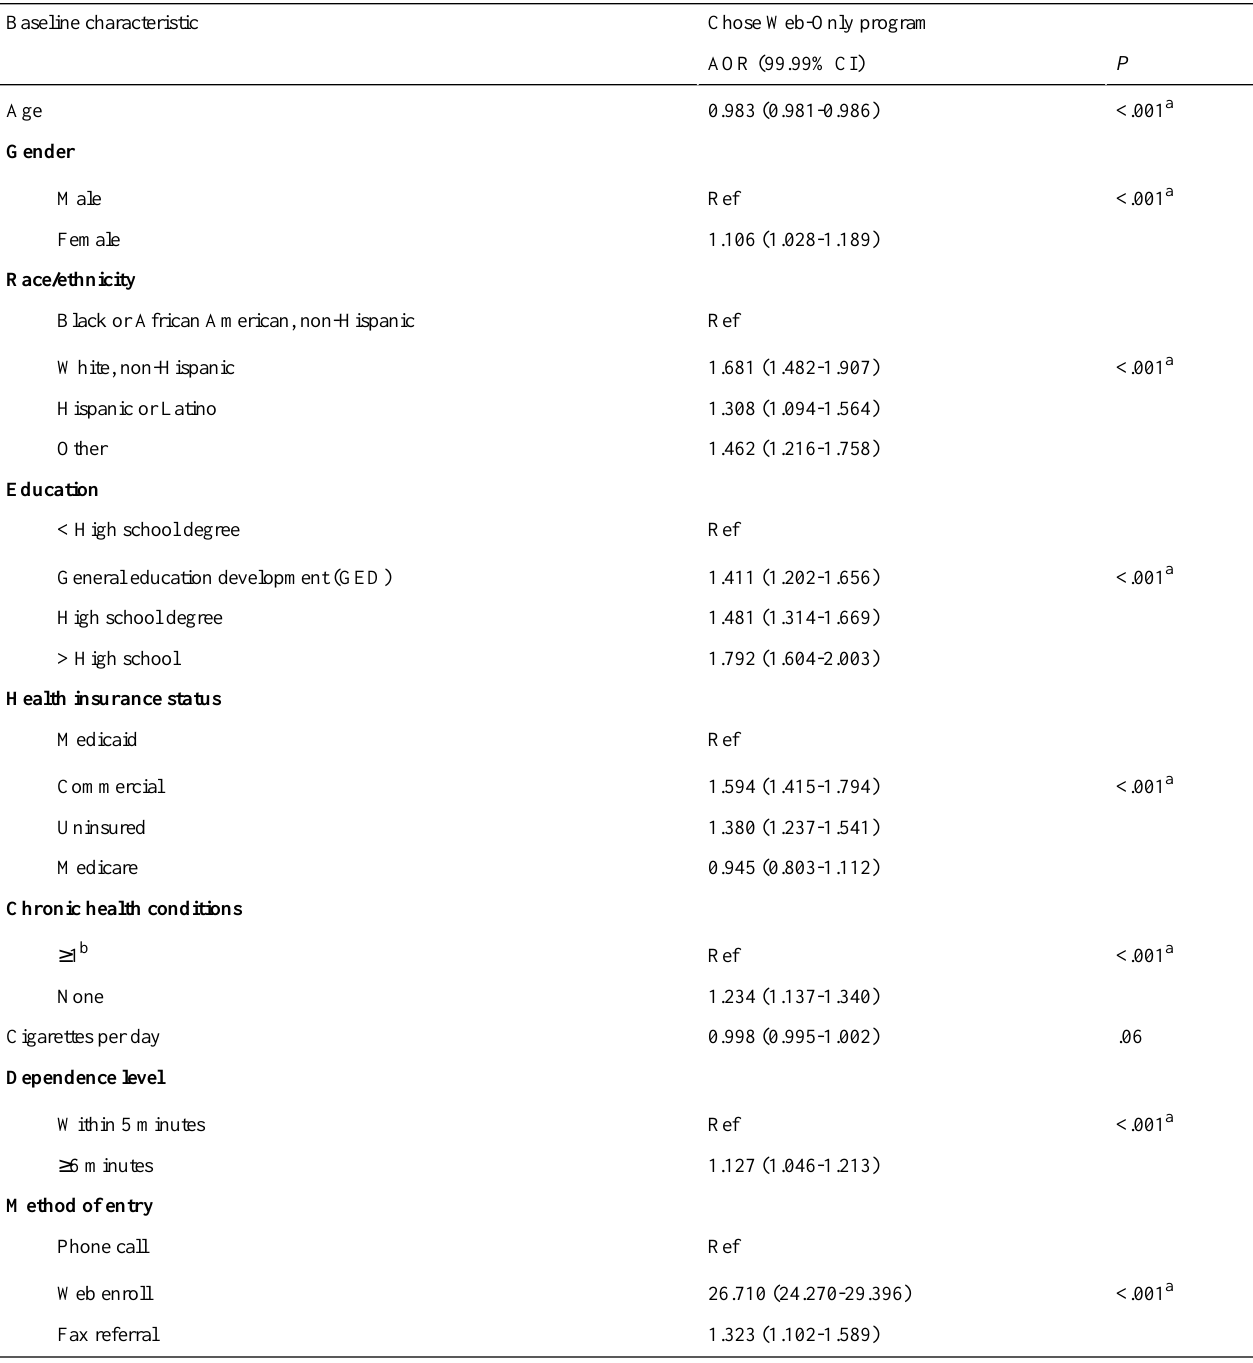
Table 2. Multivariable model of the relationship of participant characteristics and program choice between Phone/Web versus Web-Only programs.